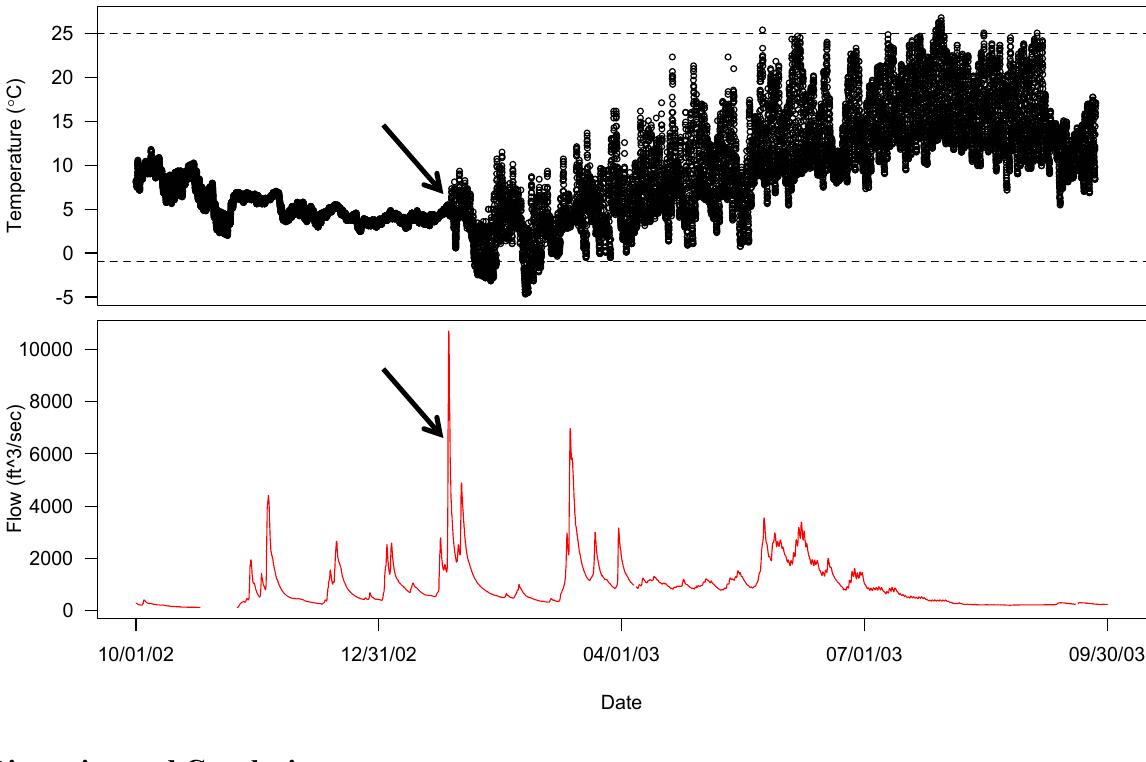
Figure 4. Identifying a dewatering event by comparing temperature records with publicly available flow